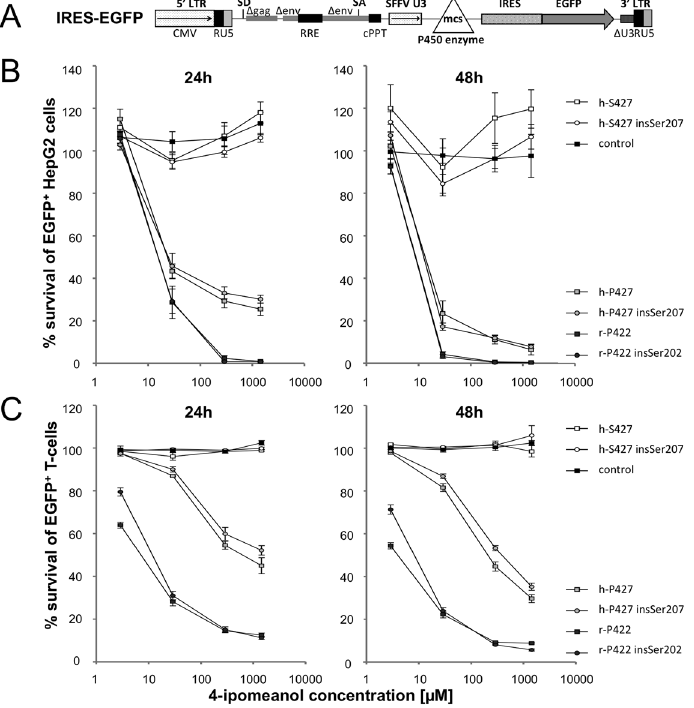
an IRES-EGFP site. CMV: CMV promoter; SD: splice donor; LTR: long terminal repeat; SA: splice acceptor; RRE: Rev responsive element, cPPT: central polypurine binding tract; SFFV U3: U3 promoter of the spleen focus-forming virus; mcs: multicloning site; IRES: internal ribosomal entry site; EGFP: enhanced green fluorescent protein. (B) Toxicity of HepG2 cells after 4-IPO exposure. Survival of EGFP+ HepG2 cells (%) after 24 and 48 h of incubation with 0, 2.9, 29, 290 or 1450 μ M 4-IPO as measured by flow cytometry. The cells stably expressed the different CYP4B1 enzymes: h-S427: human wild-type (isoform 1); h-S427 insSer207: human wild-type with insSer207 (isoform 2), h-P427: human mutated p.S427P (artificial); h-P427 insSer207: human mutated p.S427P with insSer207 (artificial); r-P422: rabbit wild-type (isoform 1); r-P422 insSer202: rabbit with insSer202 (artificial). For each construct, the mean ± standard error of the mean (SEM) values are shown from at least three independent experiments. The transduction efficiency of HepG2 cells (not shown) was (cid:1) 90%, as determined by EGFP expression in flow cytometry. (C) Toxicity of T cells after 4-IPO exposure. Survival of EGFP+ primary human T cells (%) expressing the different CYP4B1 proteins [listed for (B)] after 24 and 48 h of incubation with increasing doses of 4-IPO as assessed by flow cytometry. For each construct, the mean ± SEM values are shown from at least three